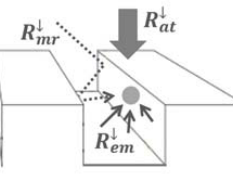
Figure 1. Scheme of the different radiative fluxes contributing to the total downwelling TIR radiation: atmospheric radiation (thick arrow), scene radiations divided between emission (thin arrow) and multiple reflections (dash arrow).